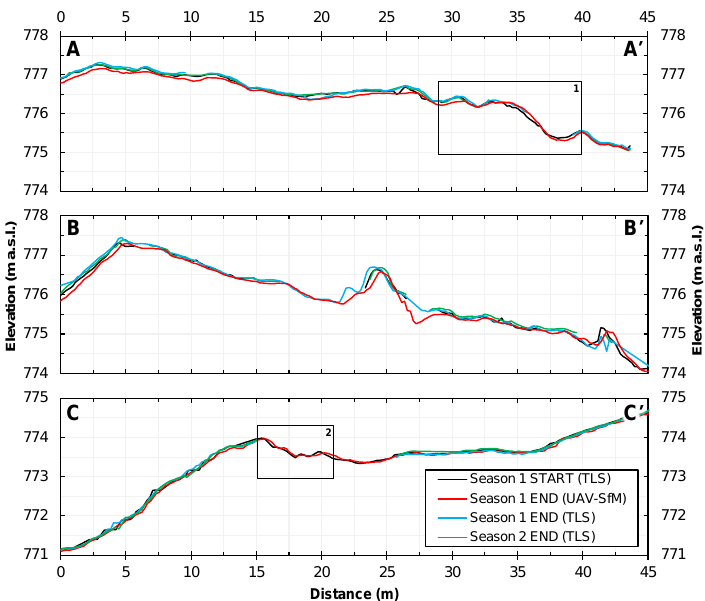
Figure 4. Moraine surface elevation profiles, extracted from gridded (0.2m 2 ) digital elevation models of TLS- and SfM-derived topographic datasets. Profile locations are shown in Figs. 3 and 6. Profiles A and B bisect the main central moraine crest, whilst profile C is located on moraine deposits at the back of the embayment. Inset numbered boxes in profiles A and C show areas referred to in the